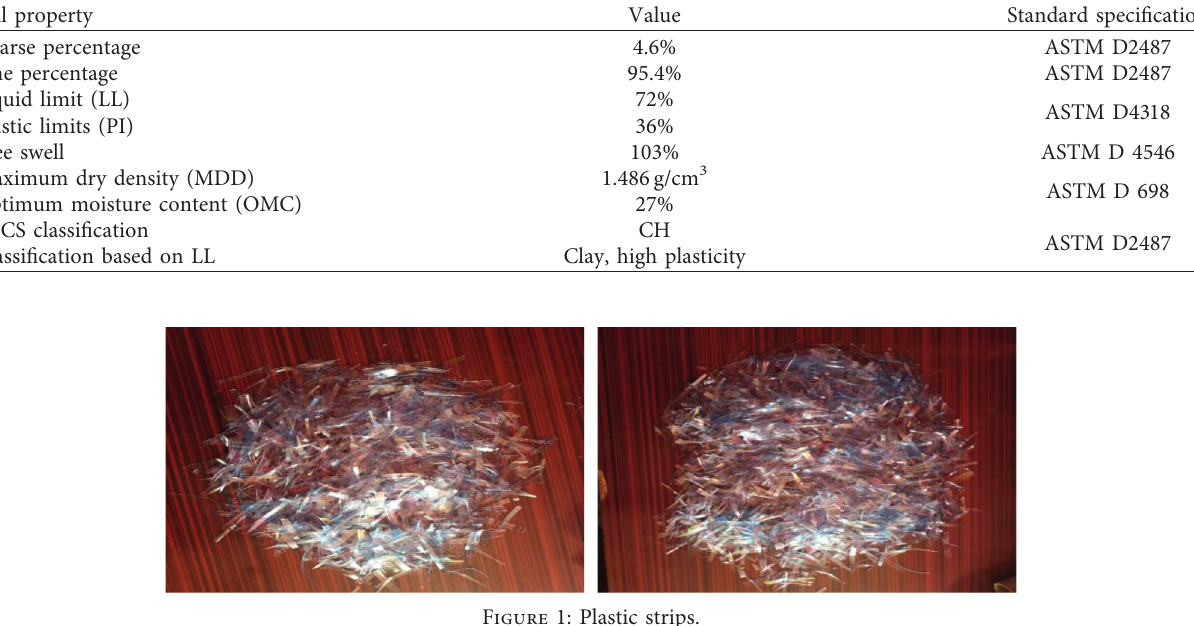
Table 1: Engineering properties of the soil sample.